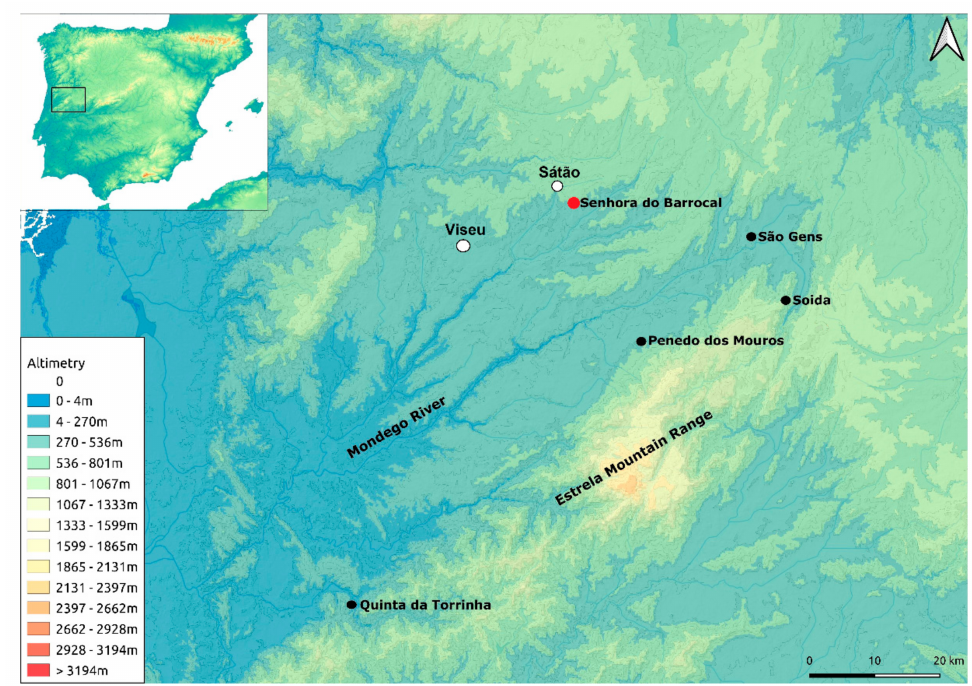
Figure 1. Location of Senhora do Barrocal (SB) and other sites in central Portugal with fruits/seeds. 2. The Medieval Site